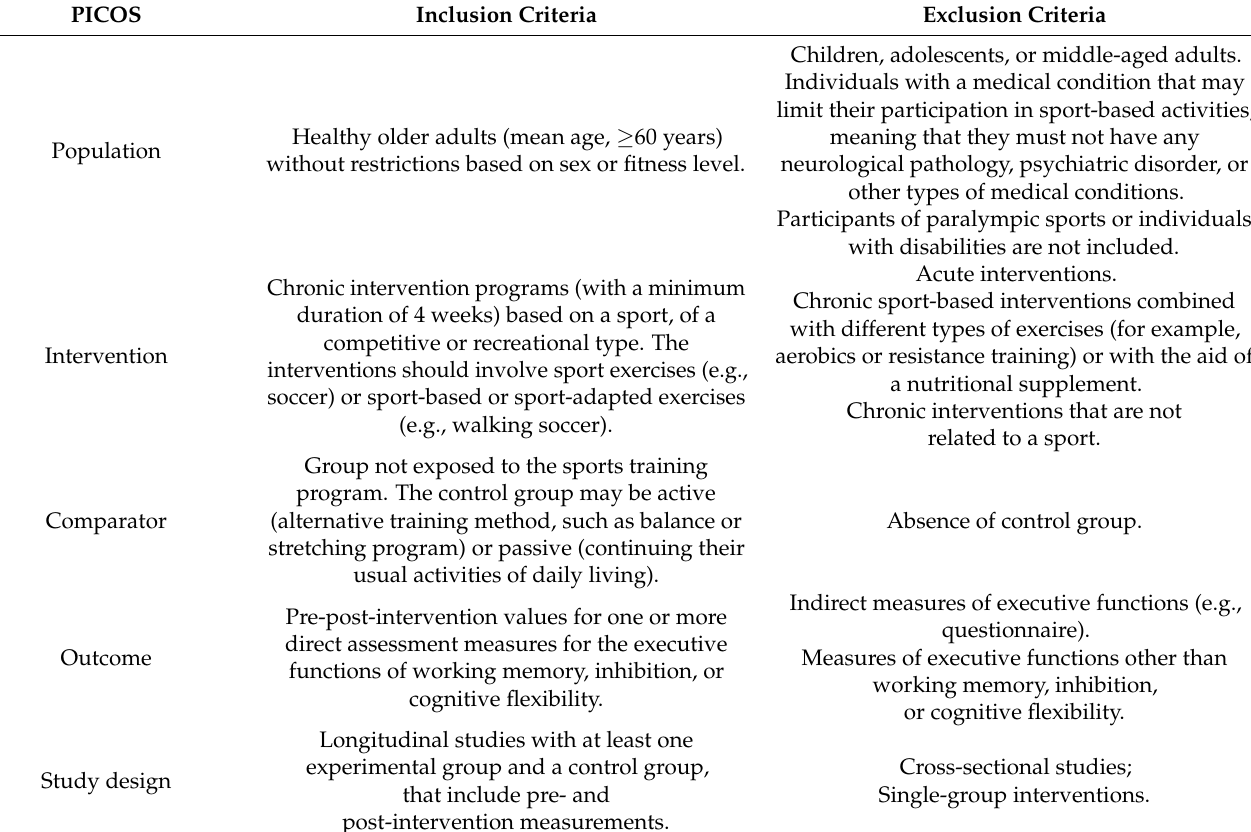
Table 1. Eligibility Criteria Based on